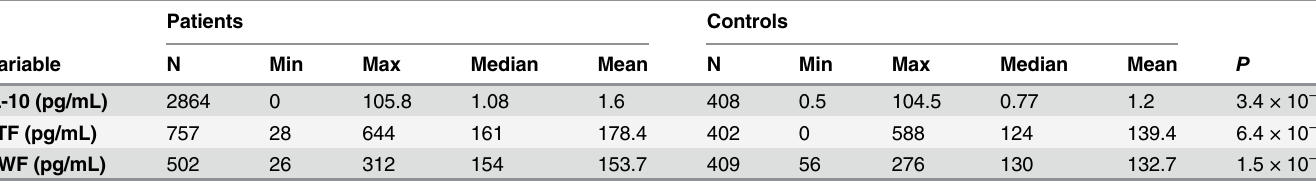
The table shows the summary statistics for three biomarkers in the ACS patients and controls. For each sub-cohort, the number of individuals with the biomarker measured is included together with the minimum, maximum, median and mean value for each biomarker. The last columns who the P-value for the difference in biomarker levels between ACS patients and controlled, estimated by Kruskal-Wallis rank-sum